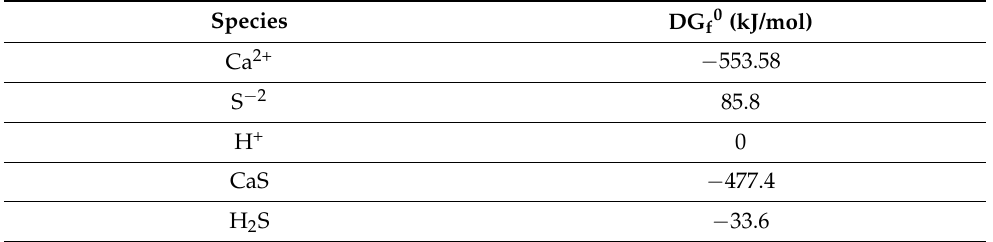
Table 1. Thermodynamic values of the Gibbs free energy of formation of various calcium- and sulfur-containing species relevant to the discussion of the pH-sensitive reactions of CaS. Species DG f0 (kJ/mol) Ca 2+ − 553.58 S − 2 85.8 H + 0 CaS − 477.4 H 2 S −